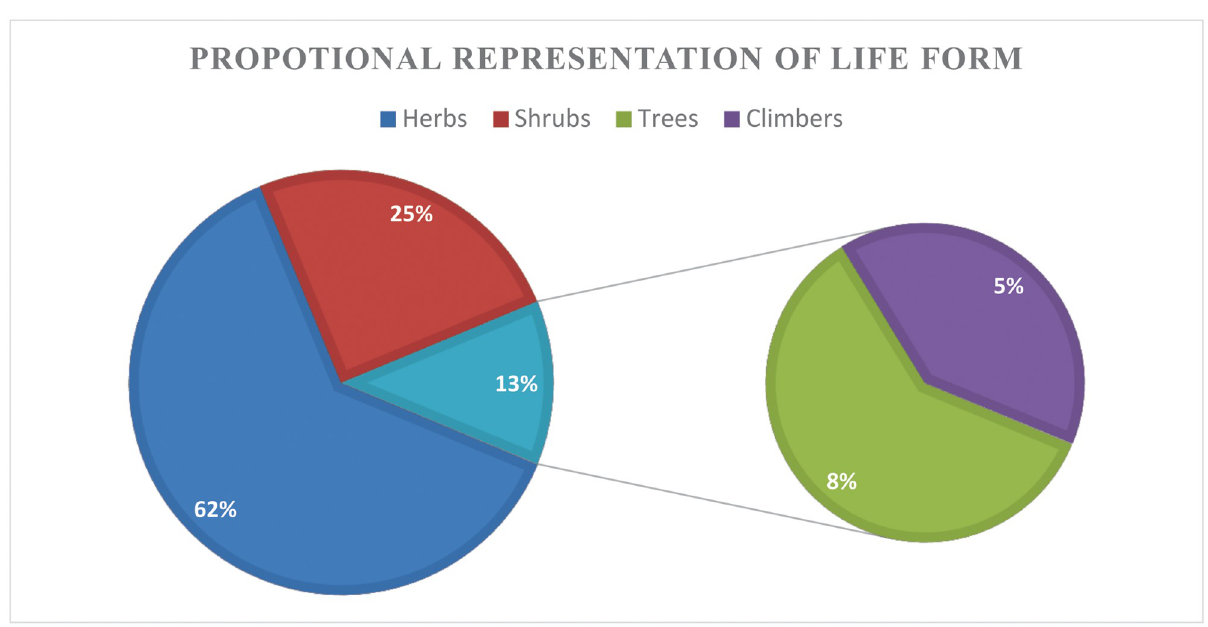
Fig 5. Proportion of life form of the plant species used in